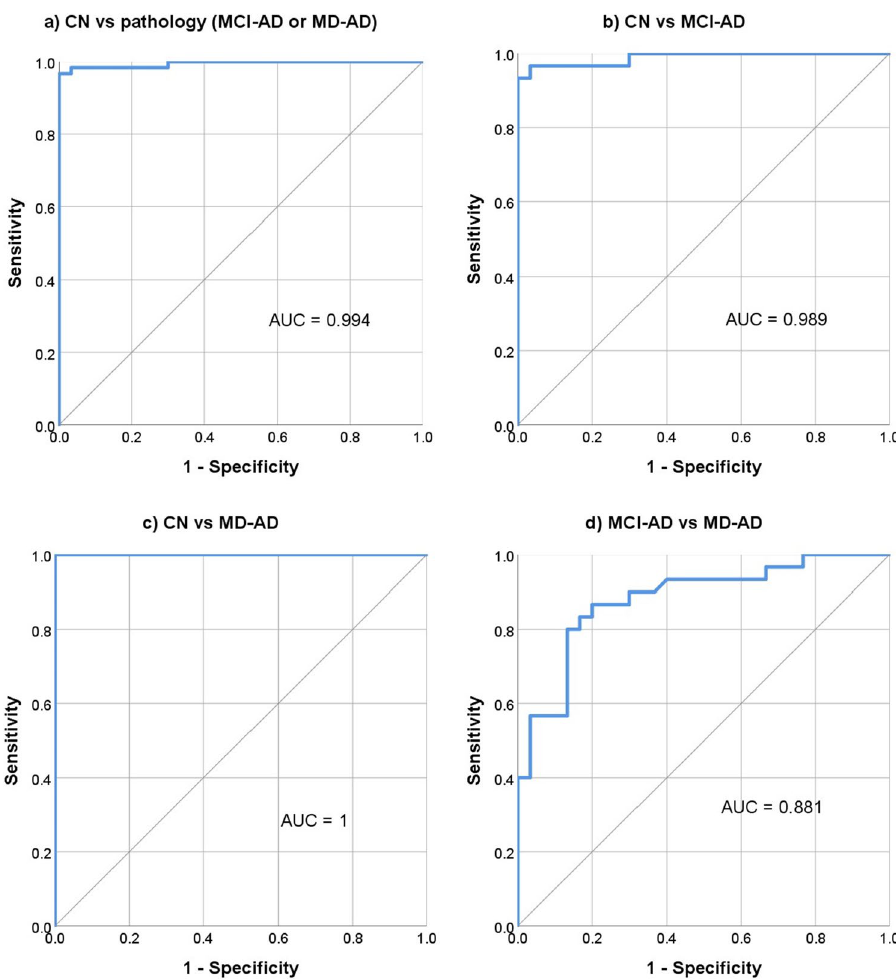
Figure 3. Performance of odor identification to ADAS-Cog 13 score ratio in differentiating between groups of